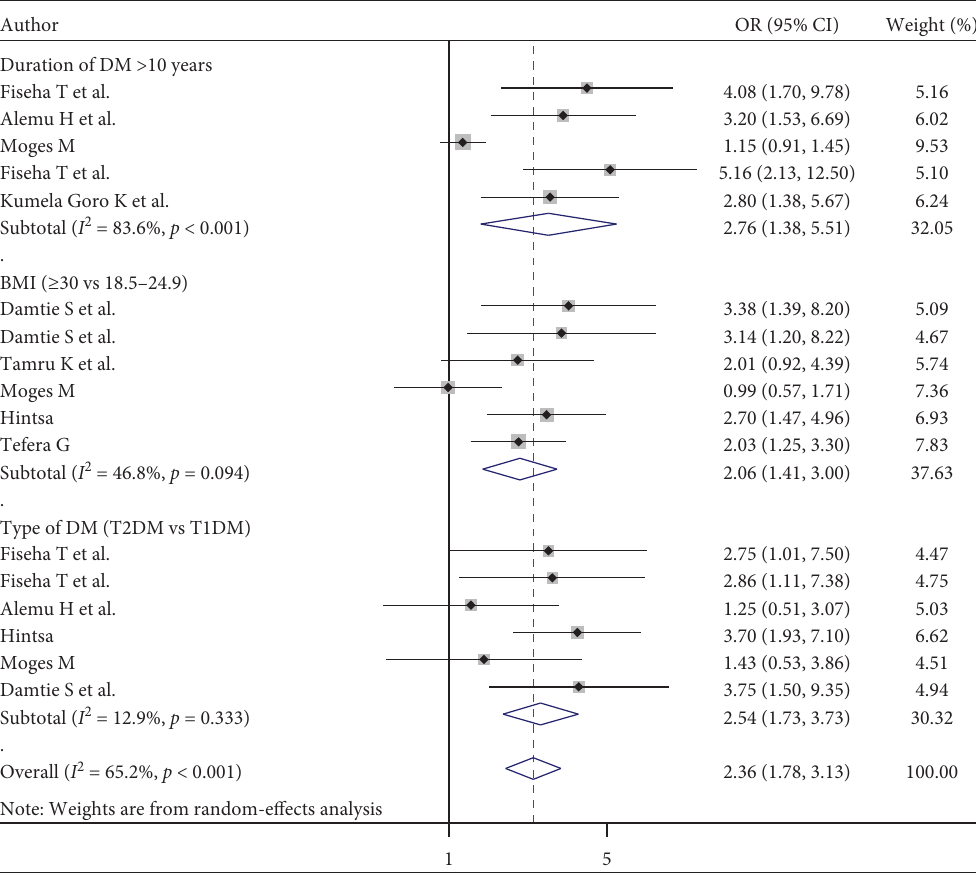
Figure 7: The effect of duration, BMI, and type of diabetes on CKD in patients with